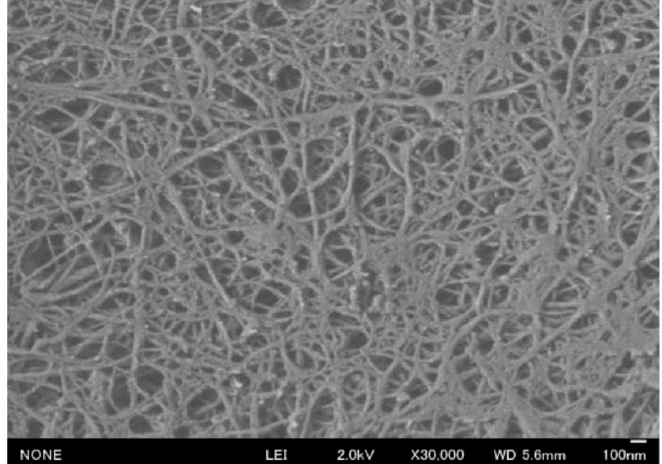
Figure 4. SEM image of chitosan nanofibers after high pressure waterjet